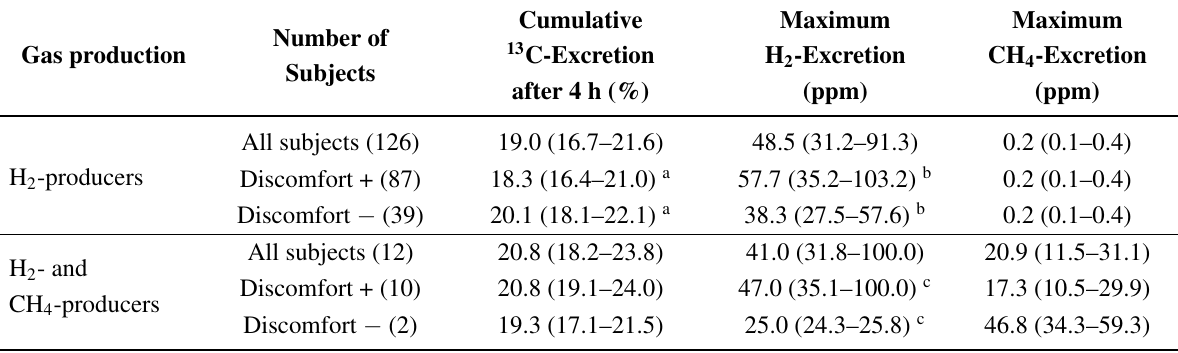
Table 3. excretion in subjects diagnosed with lactose Table 3. 13 CO 2 , H 2 and CH 4 excretion in subjects diagnosed with lactose malabsorption/SIBO.